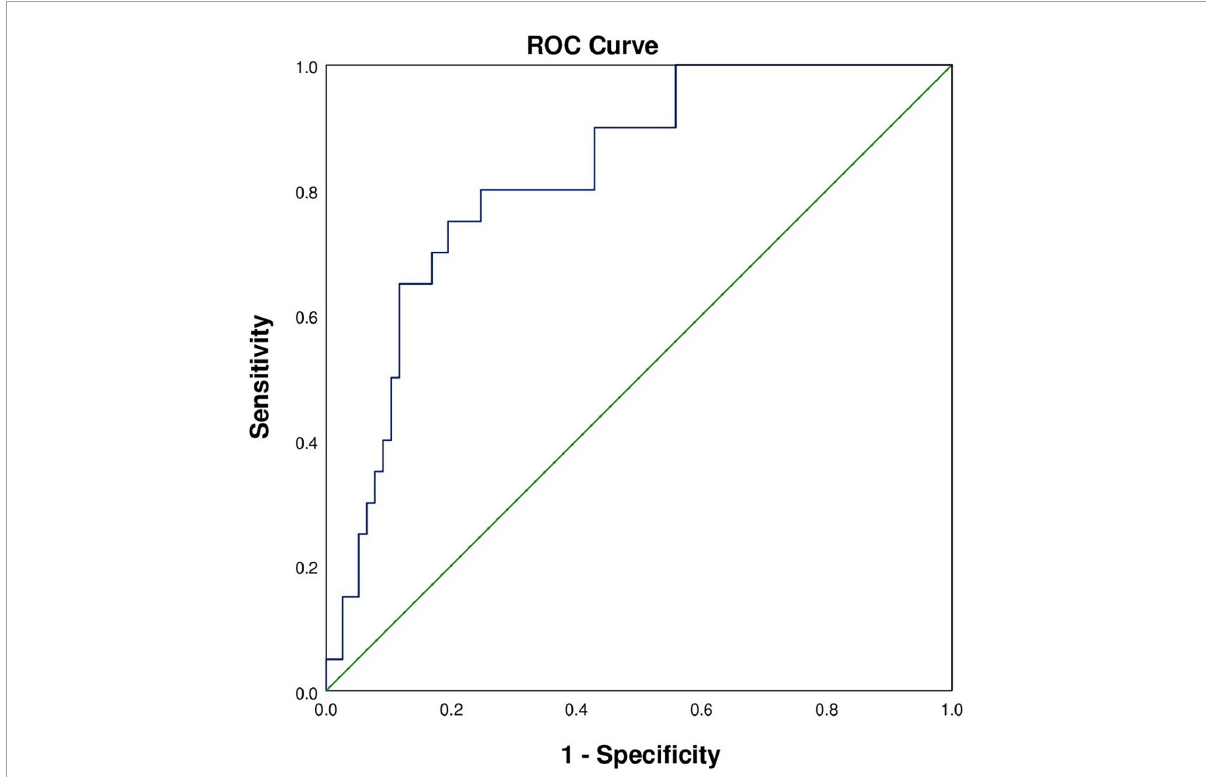
FIGURE2 Receiver operating characteristic curve for the identification of patients with myocardial injury. The area under the curve was 0.823 (SD: 0.047, 95% CI: 0.730–0.916).